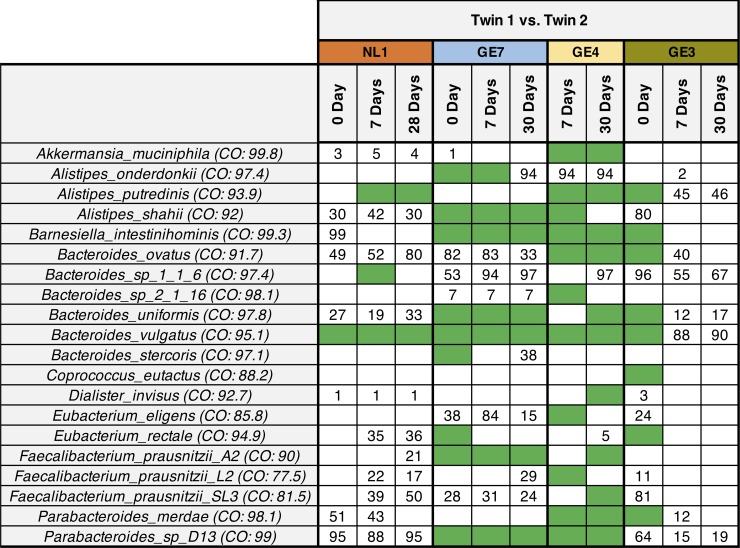
Summarized WSS scores for children twin sets.A total 20 species that were abundant across all children twin pairs obtained from Korpela et al. were selected to compare the WSS scores between each twin set (i.e. Twin 1 vs. Twin 2) from the same family over ~1 month; 28 days for Dutch family (NL1), and 30 days for German family (GE3, GE4, GE7). Each column in the table shows an individual twin set at different time points and clustered into the same family (4 different colors above the time points). Detailed sample information is shown in the S1 Table. The subsequent WSS relationships between each species were based on the cut-off values previously established by Kumar et al. to distinguish a related strain pair (WSS score > cut-off) from a non-related strain pair (WSS score < cut-off). The green boxes show that the related strain pair were observed between Twin 1 and Twin 2 from the same biological parents at a certain time point. The white boxes represent the microbial strains that we were unable to reliably determine relatedness due to the majority of the sample pairs not satisfying the criteria of WSS analysis (both samples are required to have minimum coverage > 30% and average depth > 3.5), or abundances of the species was low/absent (taxonomic composition data was reported in Korpela et al. and Xie et al.). The numbers shown in the white boxes represent the WSS scores (%) which were obtained from the pairwise comparison between Twin 1 and Twin 2 (the higher WSS scores indicate more similar/identical windows were identified between Twin 1 and Twin 2).